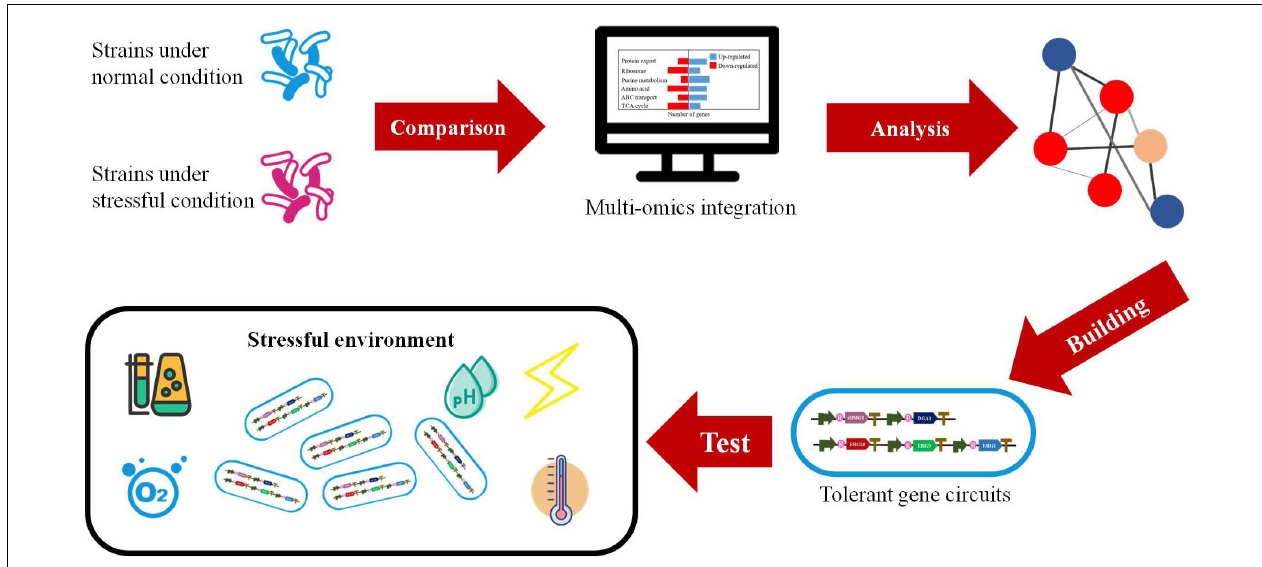
FIGURE 2 | The construction of high-efficiency cell factories designed by multi-omics.